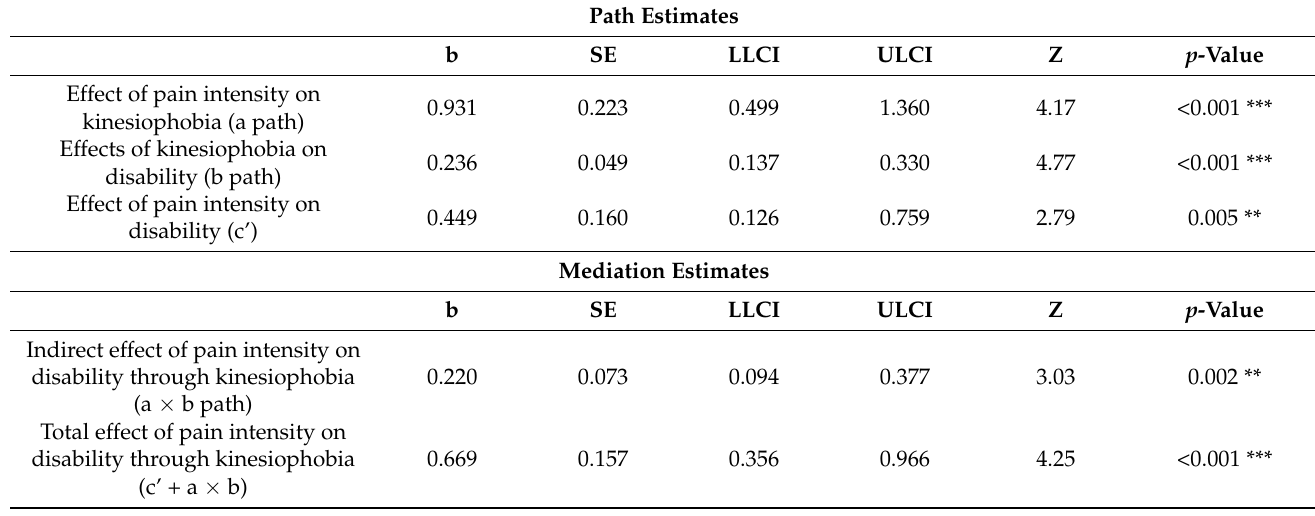
Table 3. Results of the simple mediation